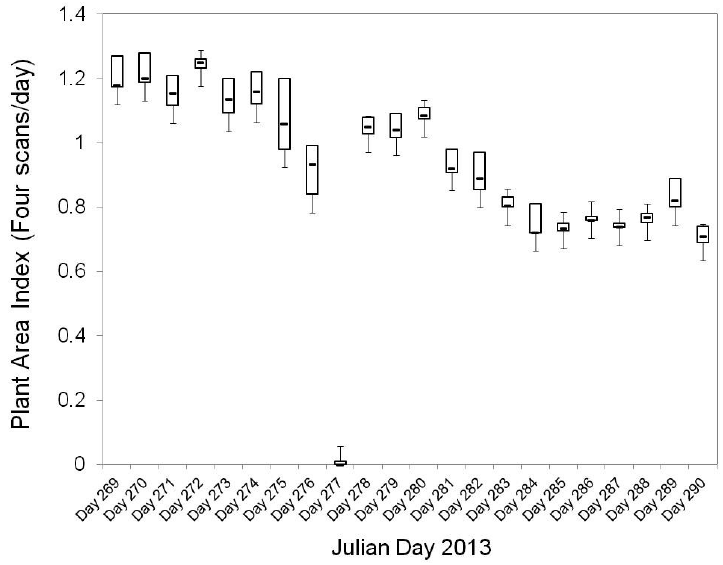
Figure 3. Time-series of the maximum cumulative Plant Area Index (PAI) values calculated by the VEGNET IML during September 26 and October 17, 2013; boxplots show the variation of maximum cumulative PAI values from all scans performed in the same night.